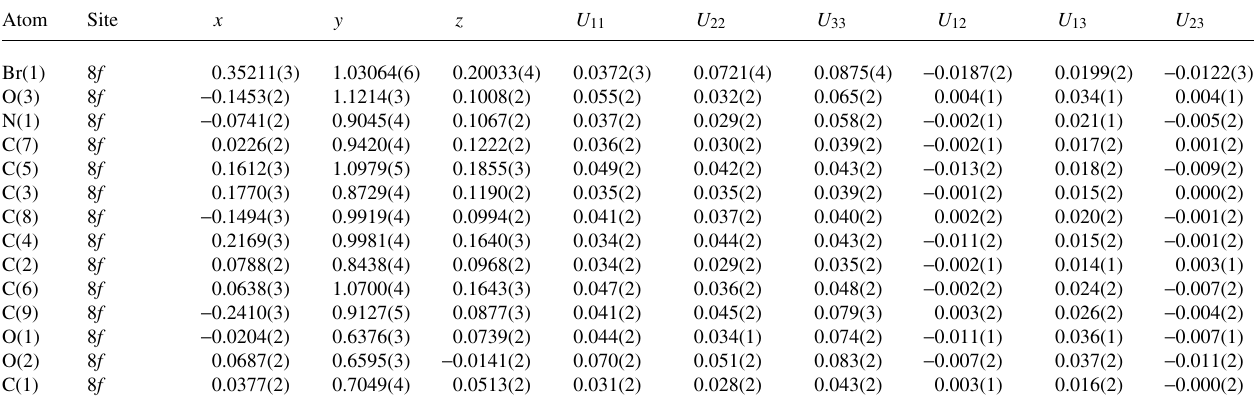
Table 3. Atomic coordinates and displacement parameters (in Å 2 )